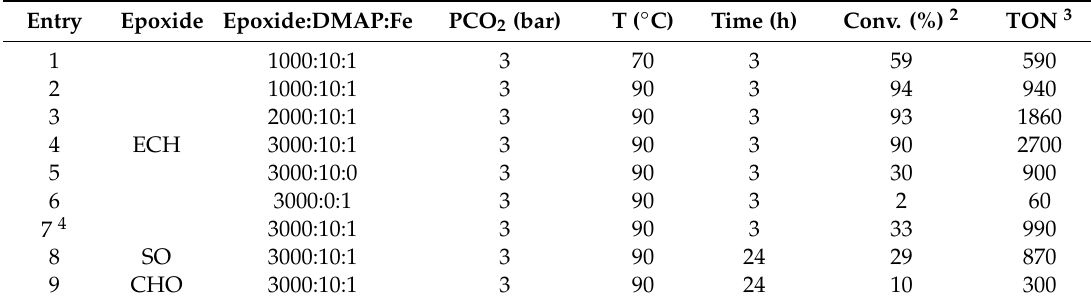
Table 2. Catalytic performance of FePc-POP in the thermal cycloaddition of CO 2 to epoxides 1